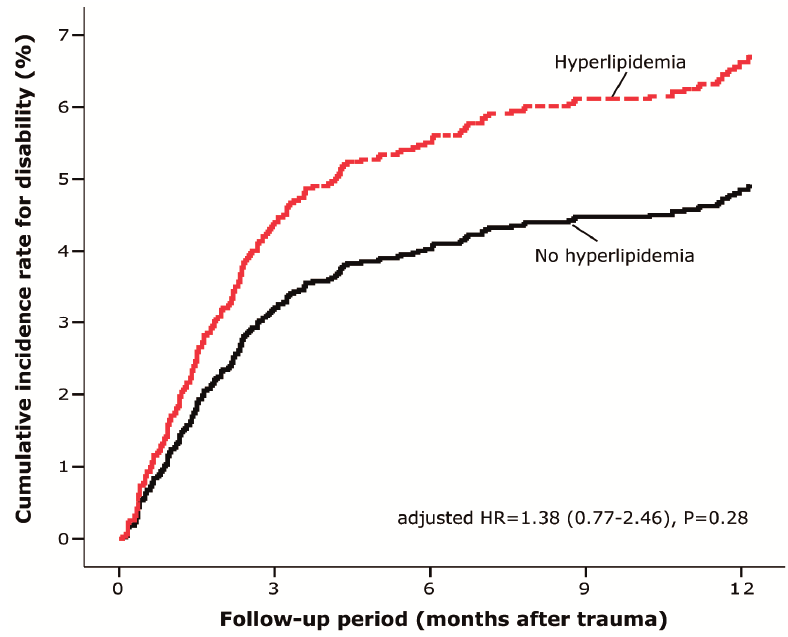
Figure 2. Cumulative incidence rate of permanent disability after lumbar SCI: Hyperlipidemia vs. normal subjects. ( n = 2844, 1998–2010,